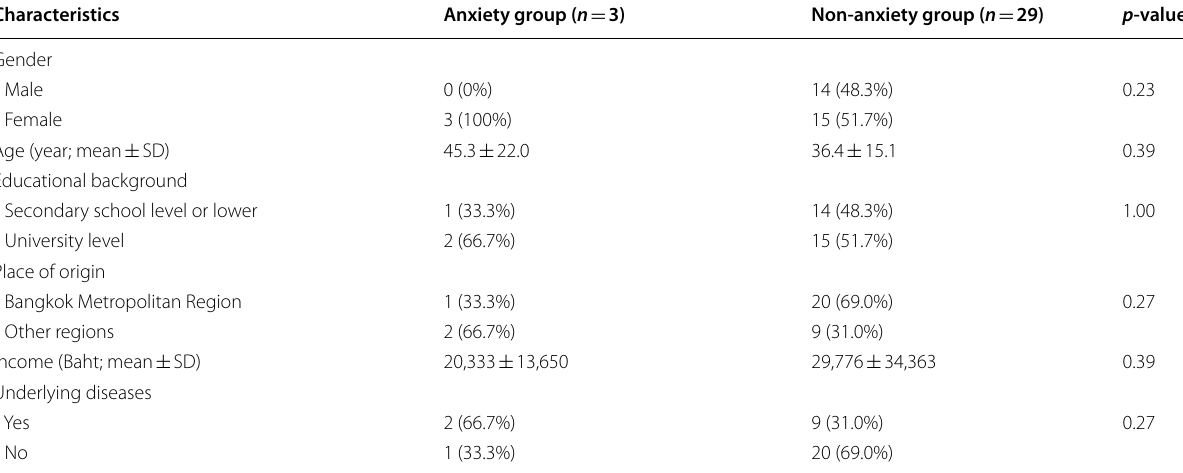
SD standard deviation